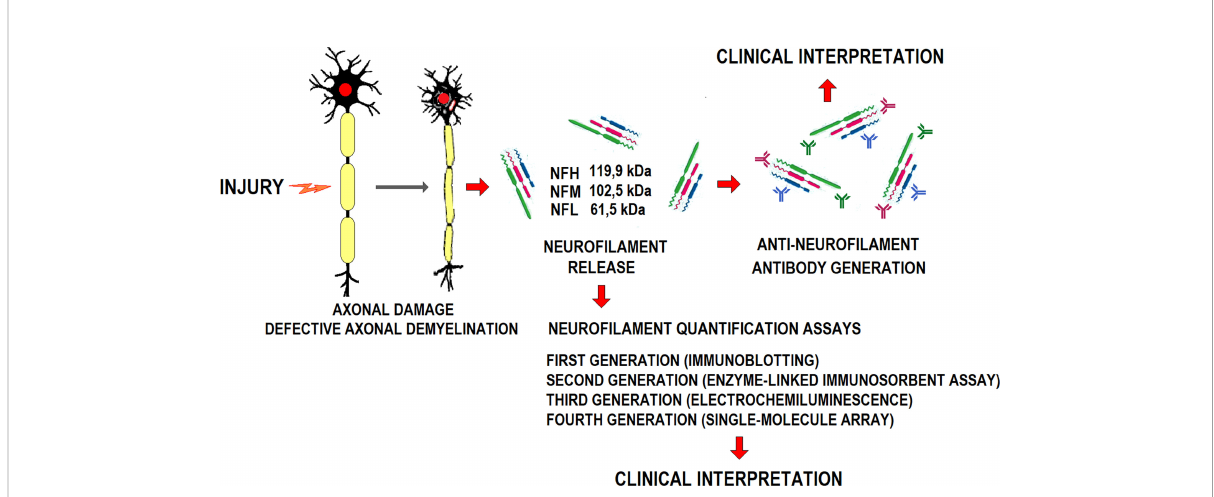
FIGURE 2 Schematic representation of axonal damage generation, the release of constitutive neuro fi laments, anti-NFL antibodies generation, and their diagnostic